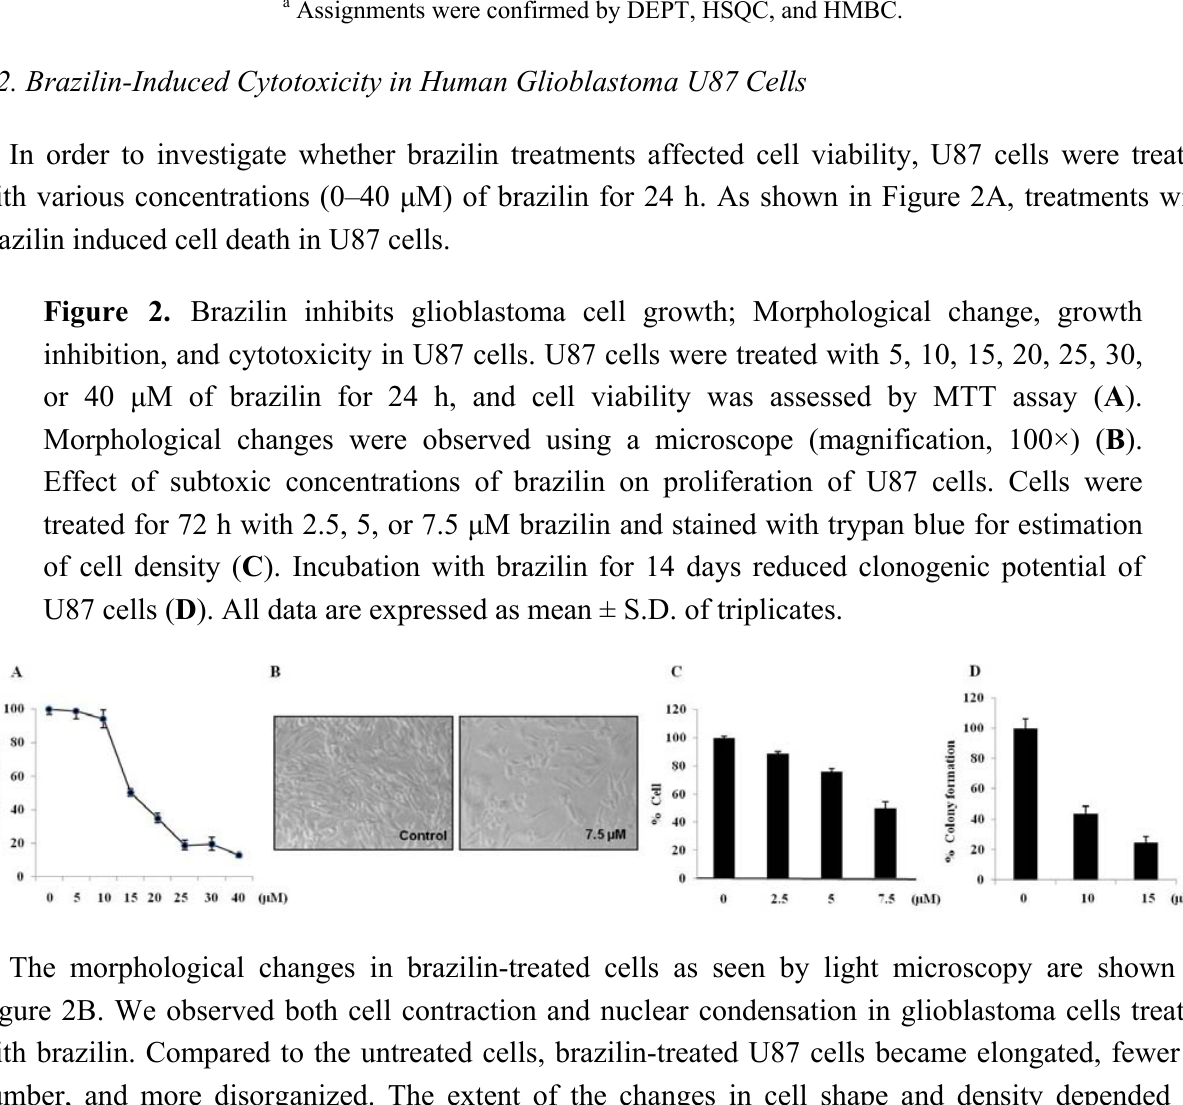
Table 1. 1 H- (400 MHz) and 13 C-NMR (100 MHz) data of compound 1 (in CD